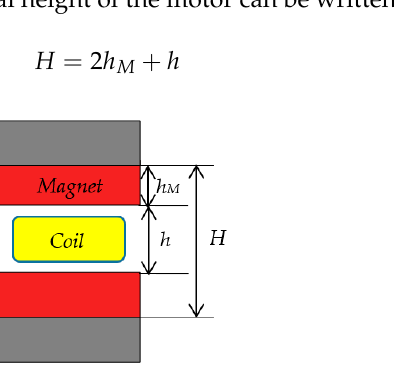
Figure 5. Side view of one coil and its relating permanent magnets.